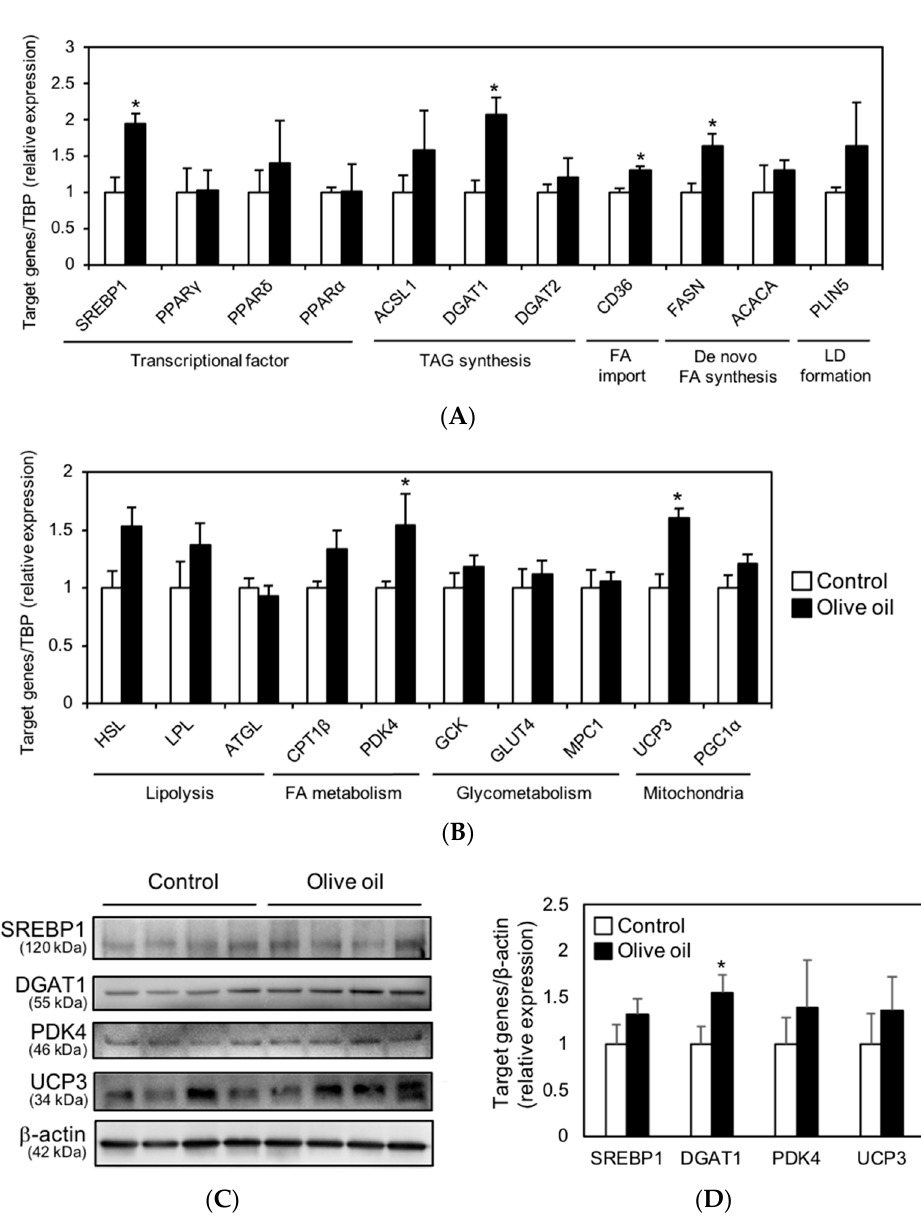
Figure 4. Transcript and protein expression levels in gastrocnemius muscle. ( A , B ) Relative expression levels of transcriptional factors (SREBP1, PPAR γ , δ , α ), genes involved in TAG synthesis (ACSL1, DGAT1, 2), FA import (CD36), de novo FA synthesis (FASN, ACACA), lipid droplet (LD) formation (PLIN5), lipolysis (HSL, LPL, ATGL), FA metabolism (CPT1 β , PDK4), glycometabolism (GCK, GLUT4, MPC1), and mitochondrial redox reaction (UCP3, PGC1 α ). Each gene was normalized to TBP expression. ( C ) Protein expression levels of SREBP1, DGAT1, PDK4, UCP3, and β -actin (loading control). ( D ) The densitometry quantification of panel A. Results are presented as means ± SE ( n = 8), *, p < 0.05 vs. control group.